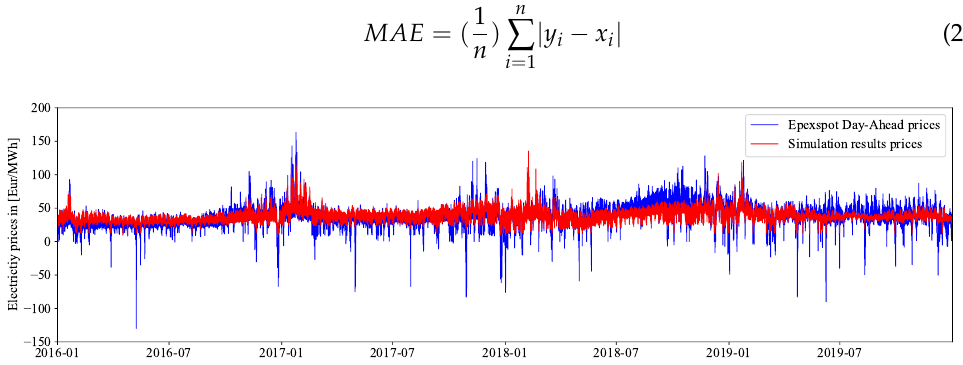
Figure 4. Comparison of day-ahead EPEX SPOT prices and model results for the year 2016–2019. The RMSE uses a quadratic scoring rule for errors; the forecasted values and corre- sponding observations are squared and then averaged. Thus, relatively higher scores are given to larger errors. The root of the squared error is usually taken to make sure that